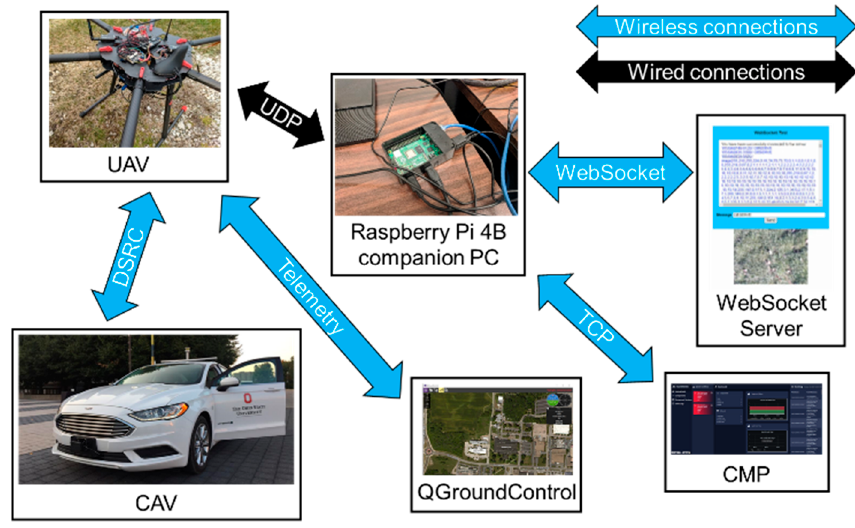
Figure 11. Schematic for Experiment #2.